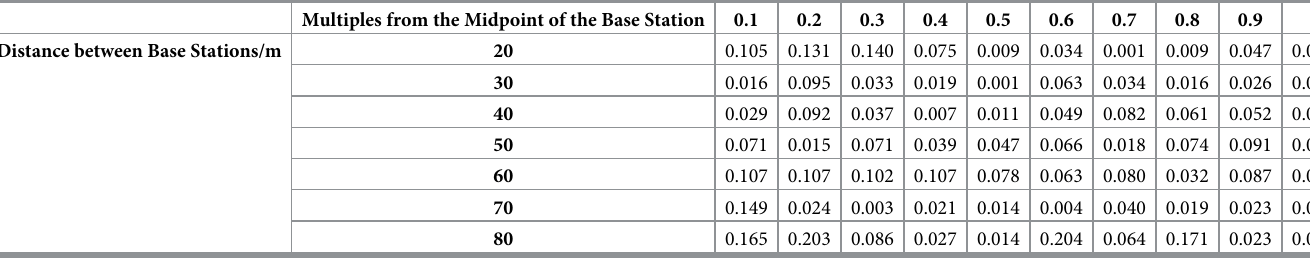
Table 2. Positioning accuracy for different label positions and base station